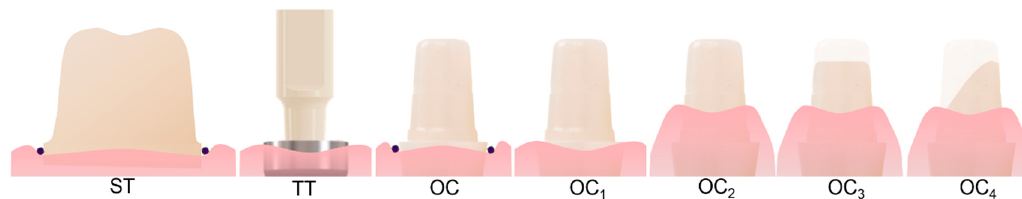
Figure 1. Schematic illustration of the investigation groups. ST, single-tooth preparation; TT, one- piece titanium implant with a scan body; OC, one-piece ZrO 2 implant; OC 1 , OC for matching with reconstruction support; OC 2 , simulated subgingival insertion of 1.5 mm; OC 3 , additional